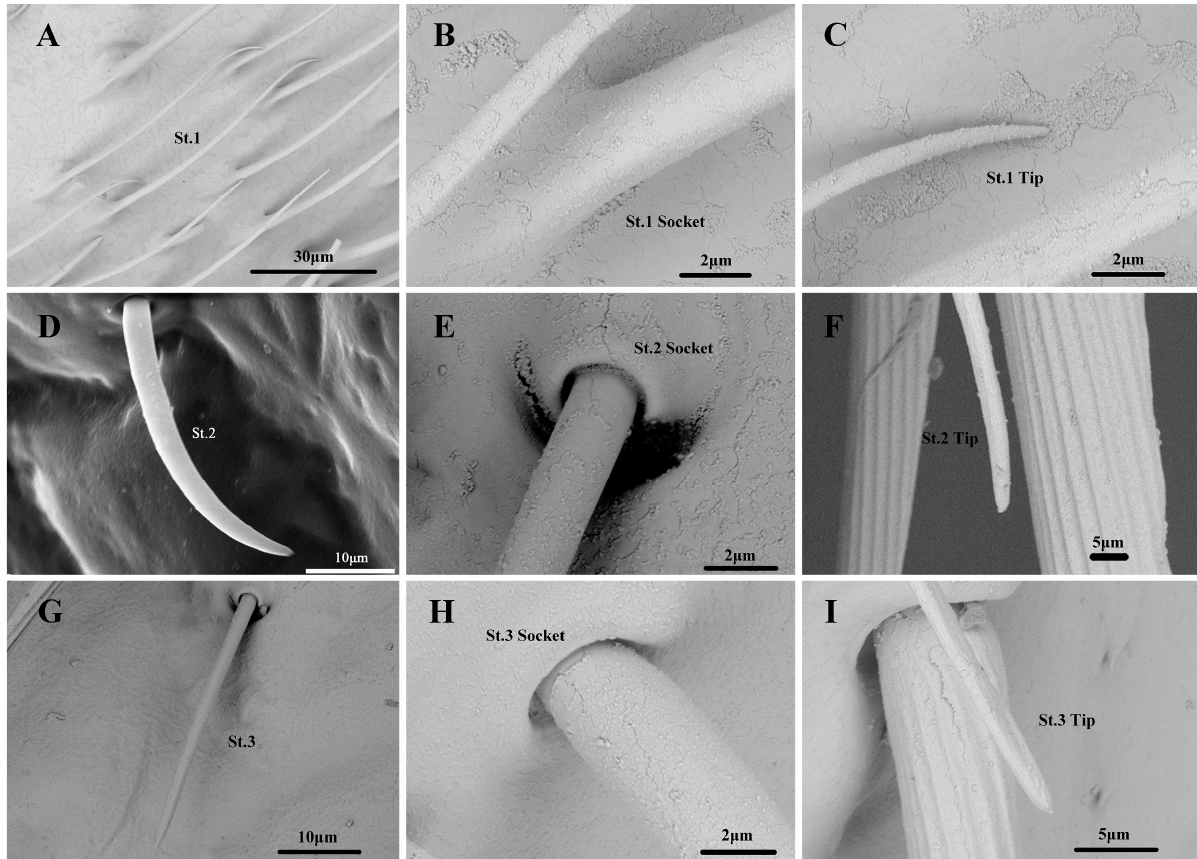
Figure 5. ( A – I ). Sensilla Trichodea of N. meleagris antennae.